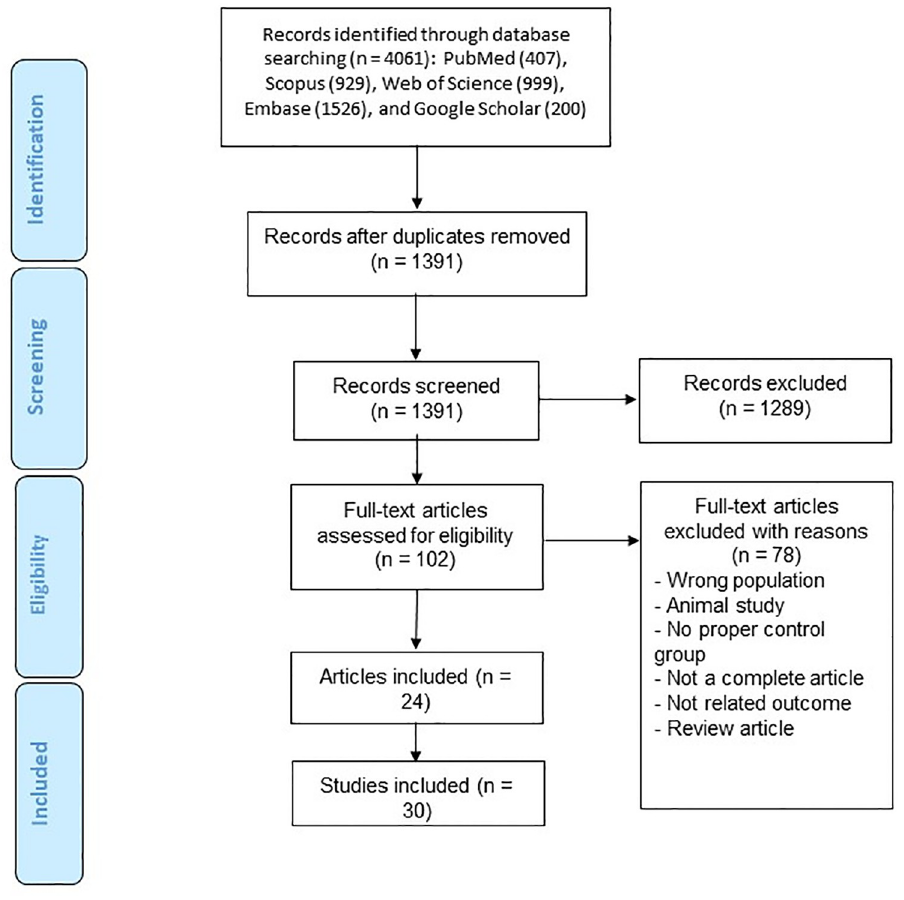
Fig 1. The flowchart of study identification and selection